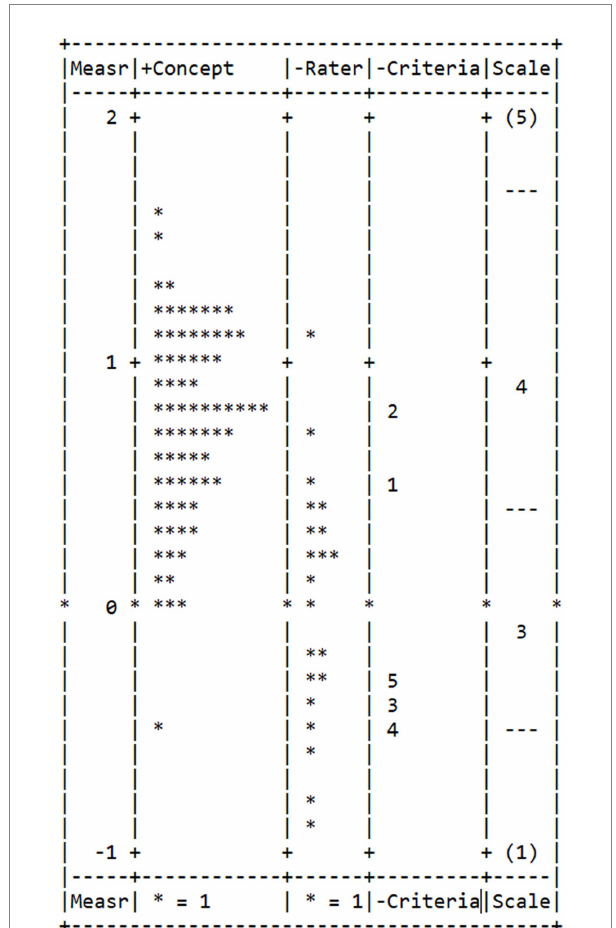
FIGURE 1 Variable map (also known as a Wright Map) showing ratings for the 74 core concepts estimated by the MFRM using core concept suitability, rater severity, and criterion difficulty. Criterion 1 = Complex; Criterion 2 = Challenging; Criterion 3 = Enduring; Criterion 4 = Fundamental; and Criterion 5 =